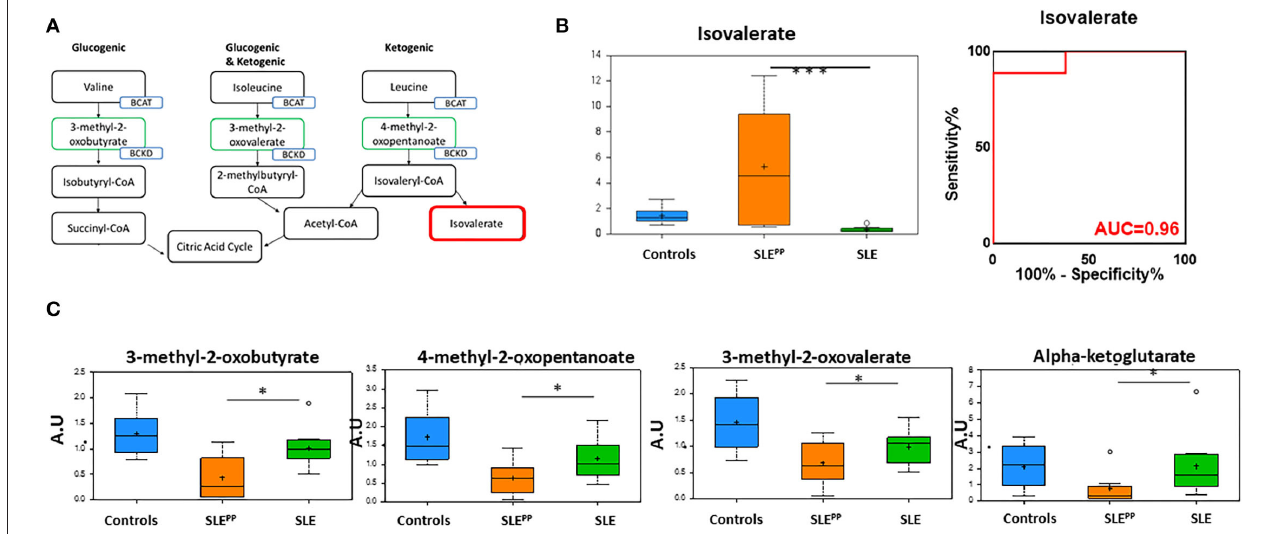
FIGURE 5 | The alpha ketoacids isovalerate, 3-methyl-2-oxobutyrate, 4-methyl-2-oxopentanoate, 3-methyl-2-oxovalerate, and alpha ketoglutarate are altered in SLE PP serum. Alpha ketoacid derivatives of branched chain amino acids ( A ; green boxes) were found to be reduced in SLE PP serum when compared to SLE serum samples and non-SLE controls. Isovalerate ( A ; red box) was increased in SLE PP sera. Serum levels of isovalerate are plotted in arbitrary units (AU) as a bar chart (B) where non-SLE controls are represented by the blue bar, SLE patients who went on to develop atherosclerotic plaques (SLE PP ) by the orange bar, and SLE patients with no plaque progression by the green bar. The most significantly reduced alpha keto acids from the metabolic screen are plotted as bar charts in arbitrary units (AU) (C) where non-SLE controls are represented by blue bars, SLE PP patients by orange bars, and SLE patients with no plaque progression by green bars. Valine, isoleucine, and leucine give rise to 3-methyl-2-oxobutyrate, 4-methyl-2-oxopentanoate, 3-methyl-2-oxovalerate, and alpha-ketoglutarate, all of which were significantly decreased in SLE PP patients as compared to non-SLE controls and control SLE patients. Metabolite comparisons between groups were carried out using